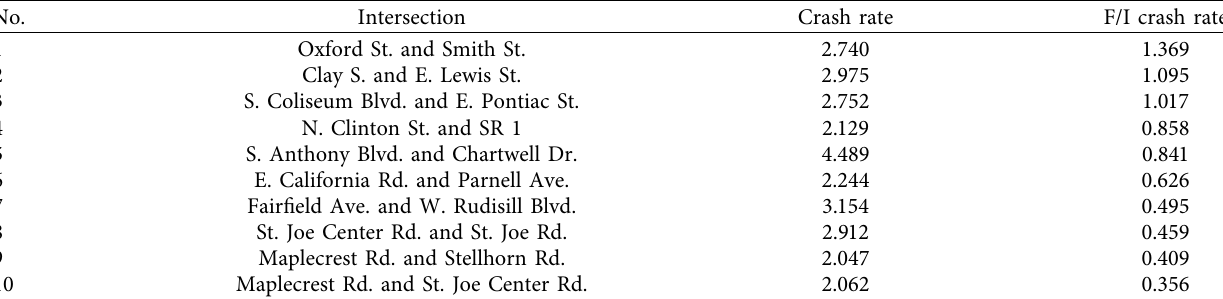
Table 2: Total and F/I crash rate for the top ten intersections.